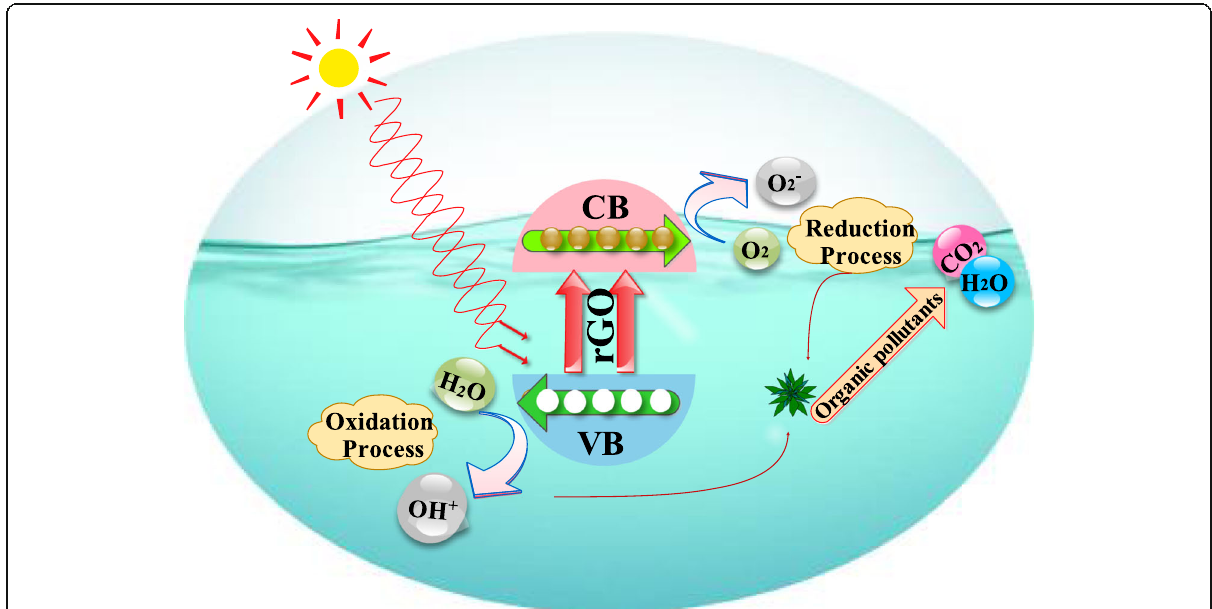
Fig. 2 Photocatalytic mechanism for dye degradation in the presence of